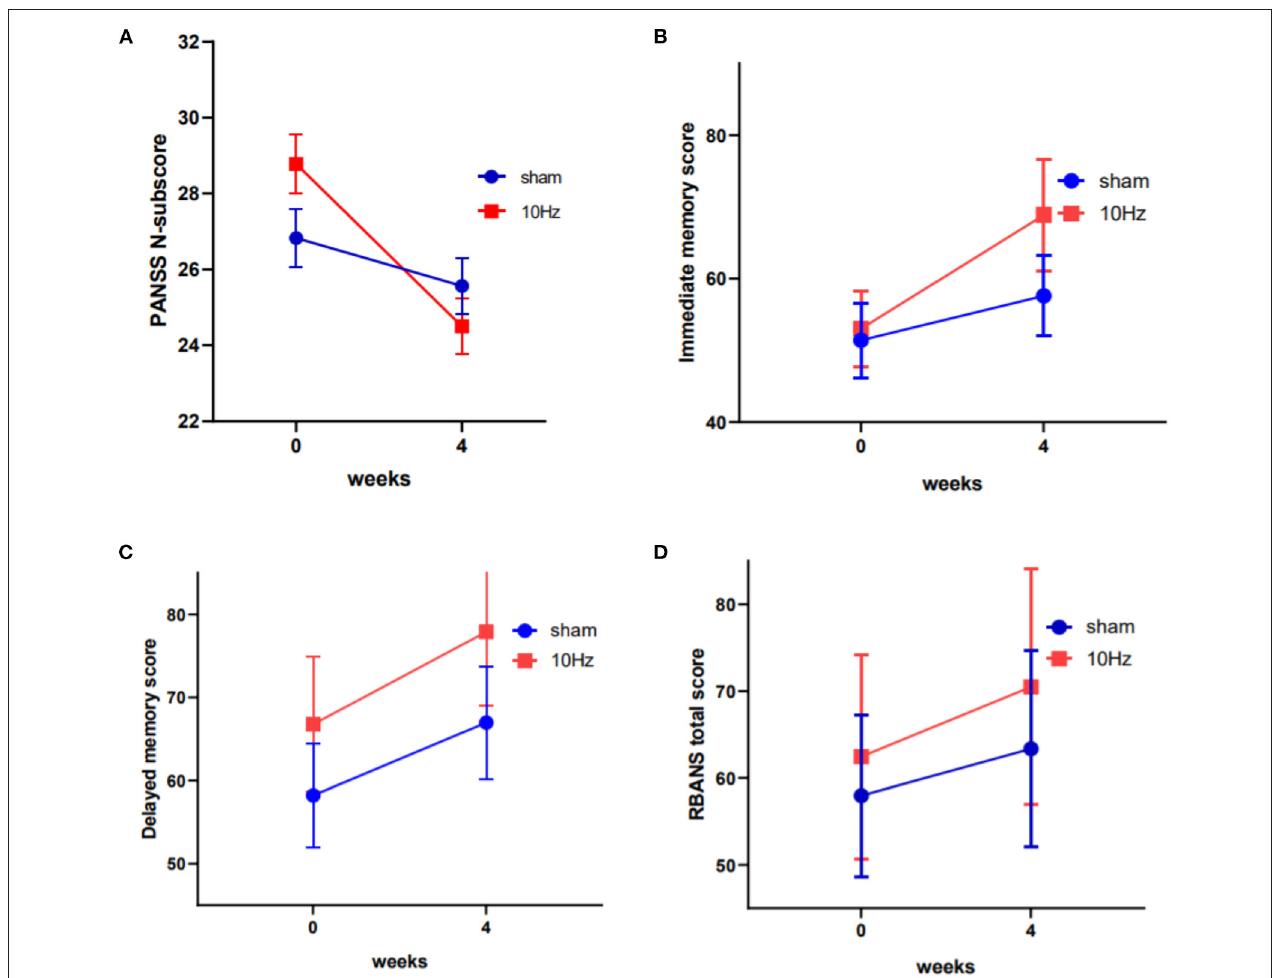
FIGURE 1 | Changes in the PANSS negative symptom scores, the RBANS immediate memory scores and the RBANS delayed memory scores between active rTMS and sham group at baseline and endpoint (4th week) (A–C) . Changes in the total score of RBANS between the two groups was of marginal significant (D)